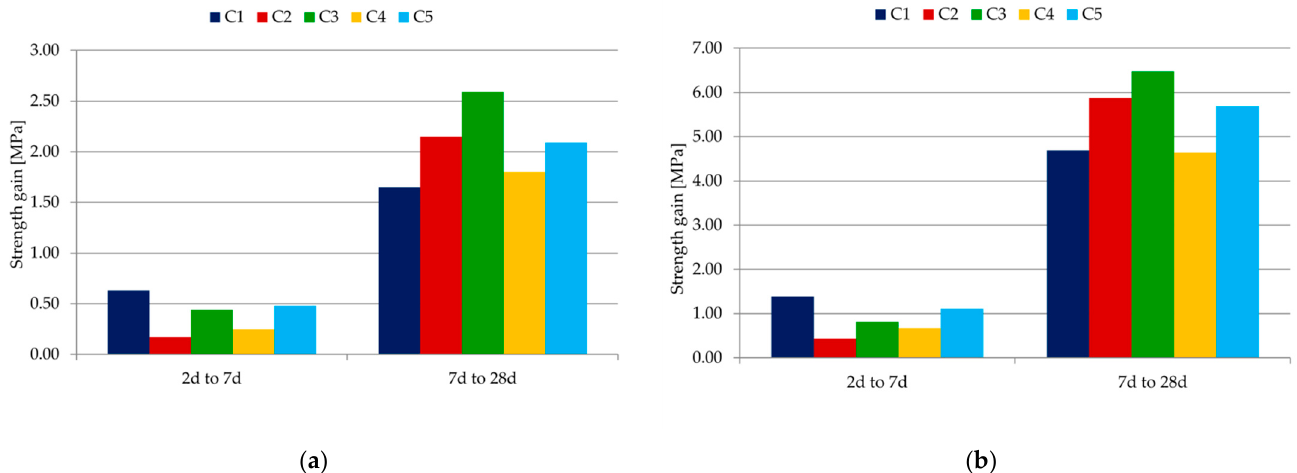
Figure 7. ( a ) Flexural strength gain over time. ( b ) Compressive strength gain over